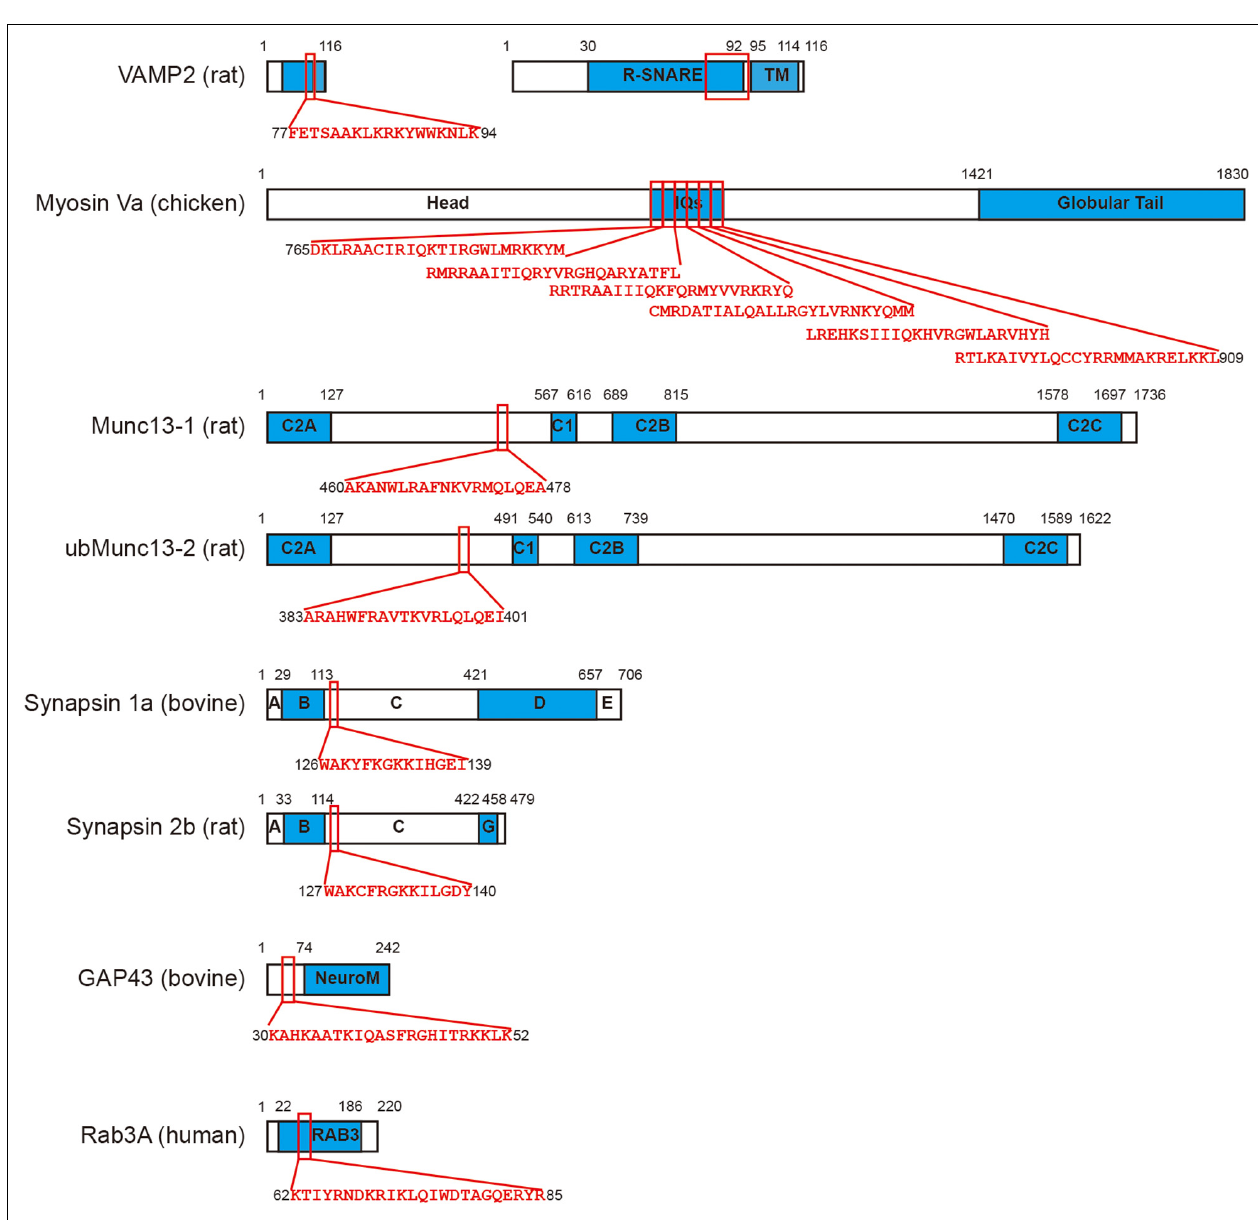
FIGURE 2 | CaM directly binds with a series of functional proteins in exocytosis. VAMP2 (Quetglas et al., 2000), myosin Va (Espindola et al., 1992), Munc13-1, ubMunc13-2 (Junge et al., 2004), synapsin 1a, synapsin 2b (Nicol et al., 1997), GAP43 (Baudier et al., 1991), and Rab3A (Park et al., 1997) are all binding partners of CaM. The CaM binding motifs in each protein are labeled using red squares and the corresponding sequence of amino acid is shown. Please note myosin Va consists of six tandem IQ motifs that interact with CaM. Since the size of VAMP2 is relatively small, a 5-times amplification is displayed on its